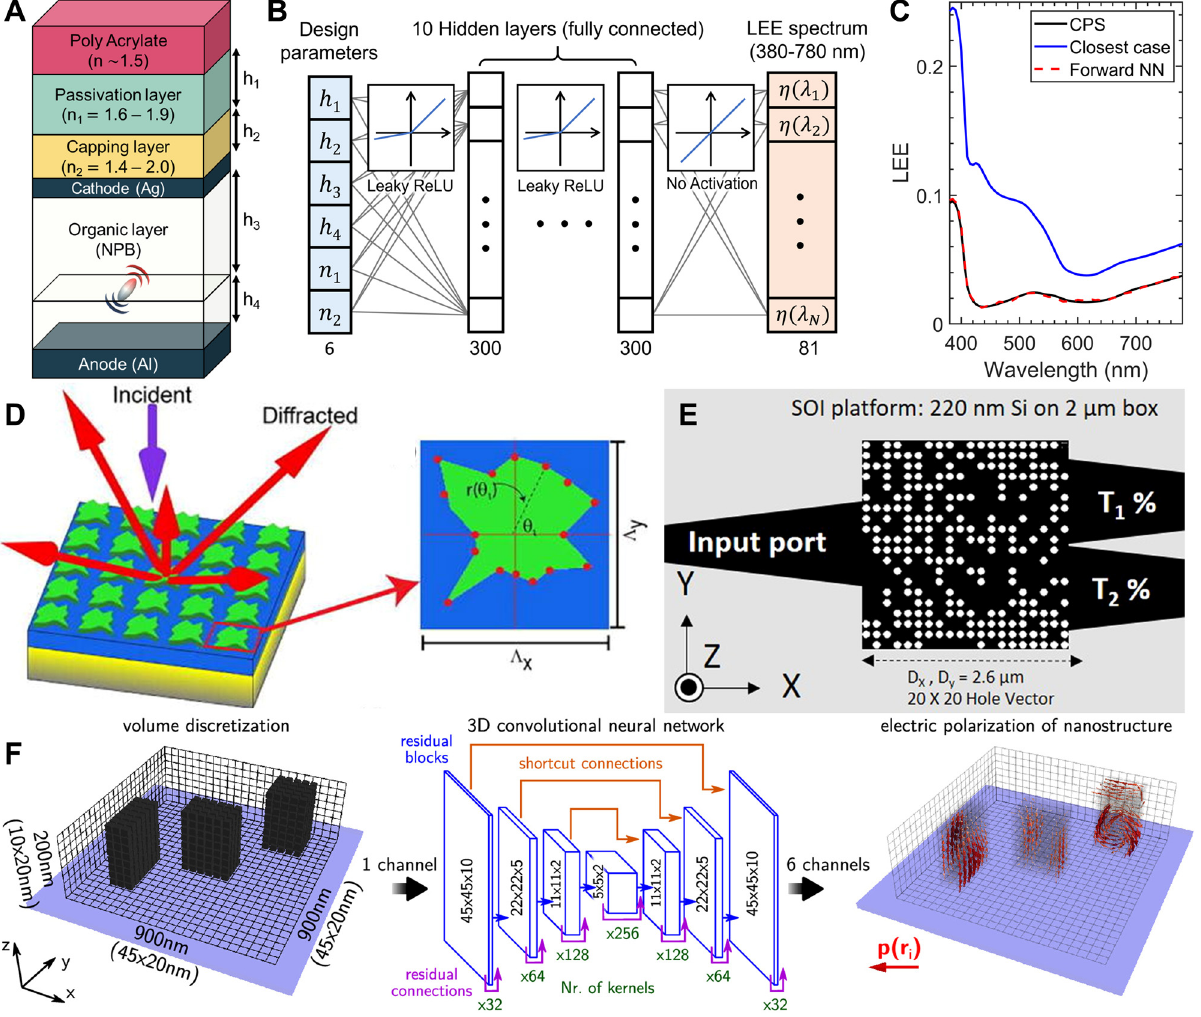
Figure 11: Use of discriminative neural networks in nanophotonics. ( A ) A schematic of simpli fi ed top-emitting OLED structure. ( B ) A diagram of the forward neural network structure. Ten hidden layers, each with 300 nodes constitute the neural network. Leaky recti fi ed linear activation (Leaky ReLU) function is used as activation functions. ( C ) The LEE curve calculated from the CPS model (black solid line), forward neural network (red dashed line). The LEE curve of the closest sample in the training dataset is plotted together (blue solid line). A – C Adapted with permission from [161]. Licensed under CC BY 4.0. ( D ) A